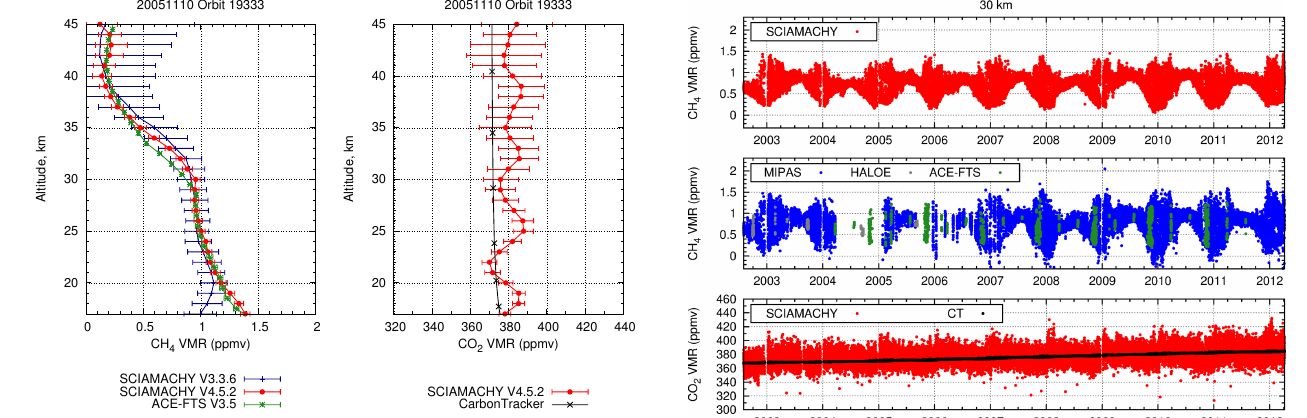
Figure 7. Top: time series of SCIAMACHY CH 4 VMRs at 30km. Middle: time series of collocated MIPAS (blue), HALOE (grey) and ACE-FTS (green) CH 4 VMRs. Bottom: time series of CO 2 VMRs at 30km. Red: SCIAMACHY data. Black: collocated Car- bonTracker